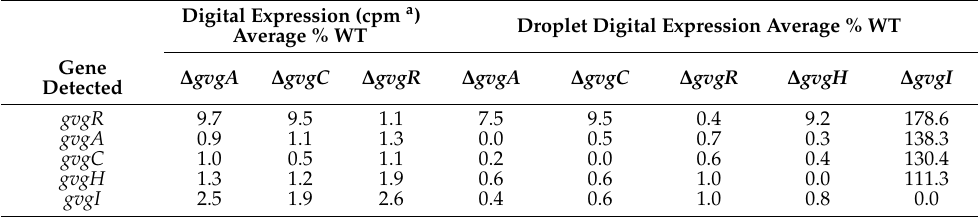
Table 3. Confirmation of gvg cluster gene expression vs. wild type in gvg cluster mutants via droplet digital